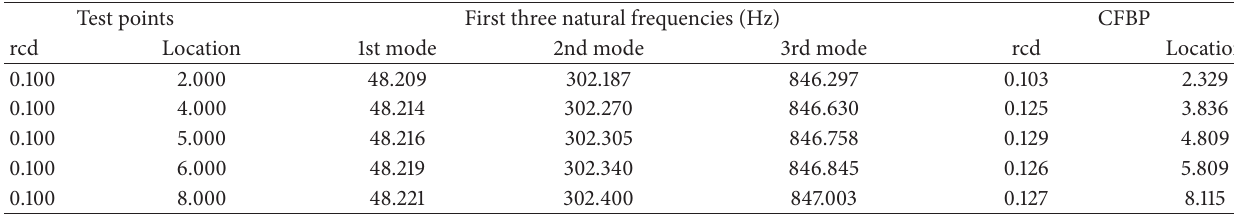
Table 1: Input data and results for CFBP network.